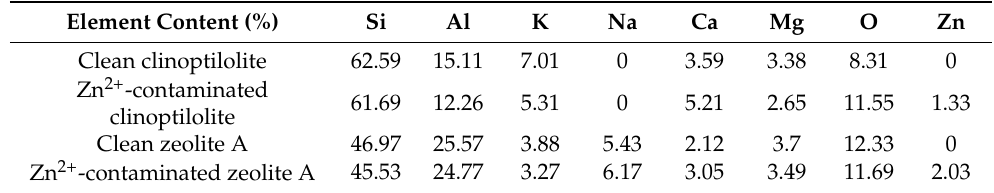
Table 2. Elemental analysis of clean clinoptilolite, zinc-contaminated clinoptilolite, clean zeolite A and zinc-contaminated zeolite A.